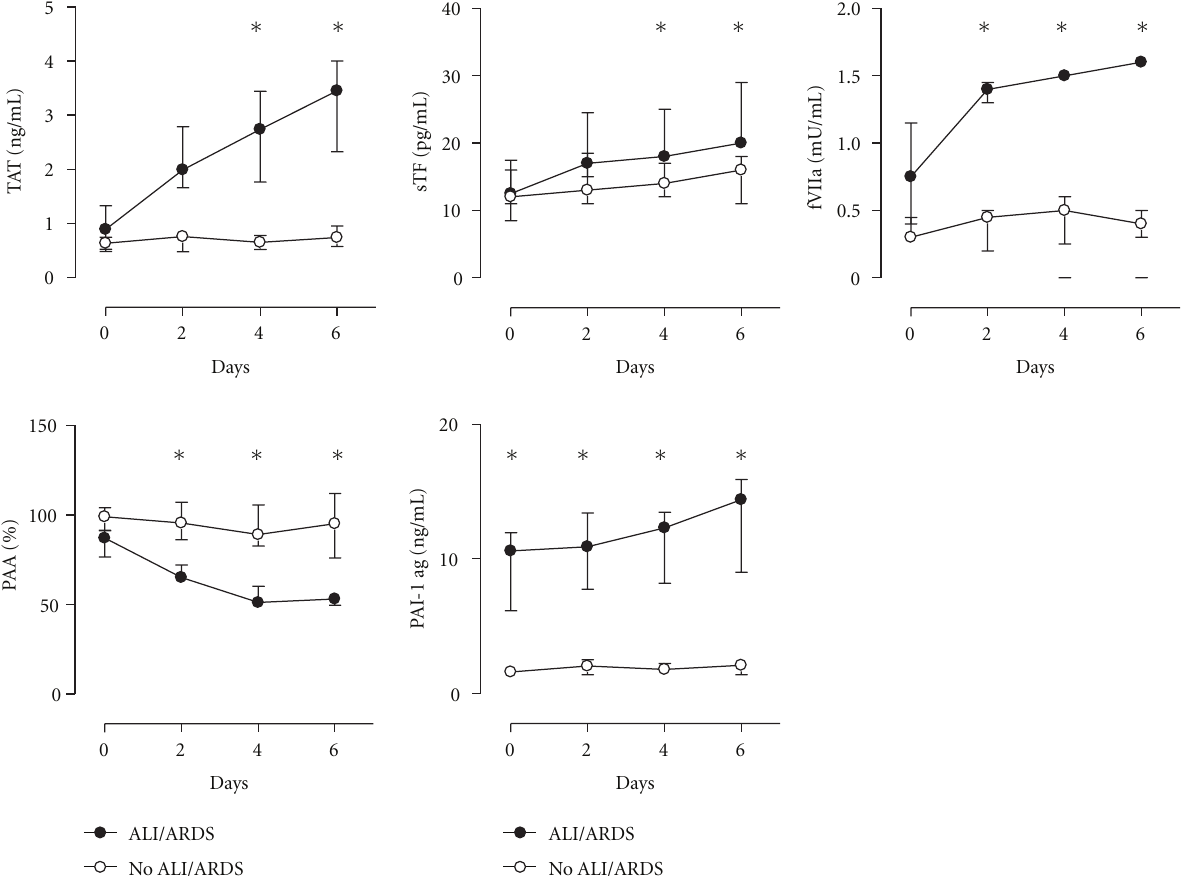
Figure 2: Bronchoalveolar levels of coagulation and fibrinolysis. Thrombin-antithrombin (TATc), soluble tissue factor (TF), factor VIIa (FVIIa), plasminogen activator activity (PAA) and plasminogen activator inhibitor type 1 (PAI-1) in patients who developed VALI (closed symbols, n = 10), and patients who did not develop VALI (open symbols, n = 10). Data are medians ± IQR. ∗ P < 0 . 05.